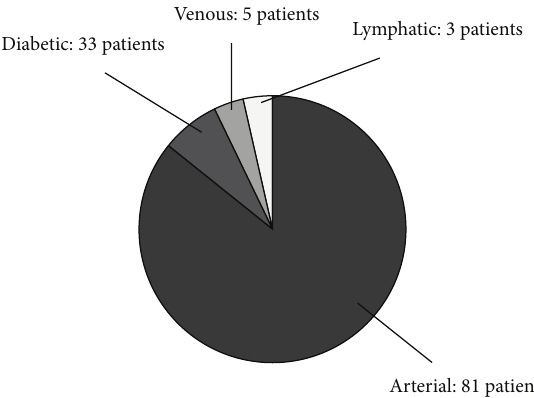
Figure 2: Cause of ulcer of lower limbs in 122 patients who visited the foot care outpatient